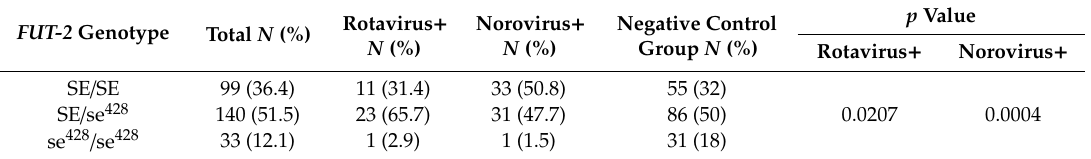
Table 5. Distributionof FUT-2 genotypesamonginfectedpatientsandcontrolsaccordingtoG428Amutation. FUT-2